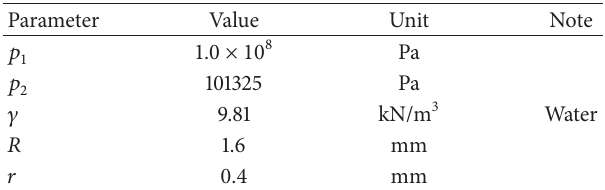
Table 1: Values of nozzle structure parameters and boundary condi- tions.